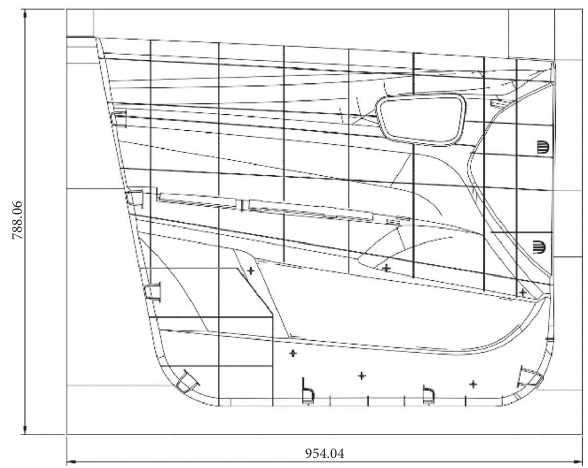
Figure 3: Core diagram.